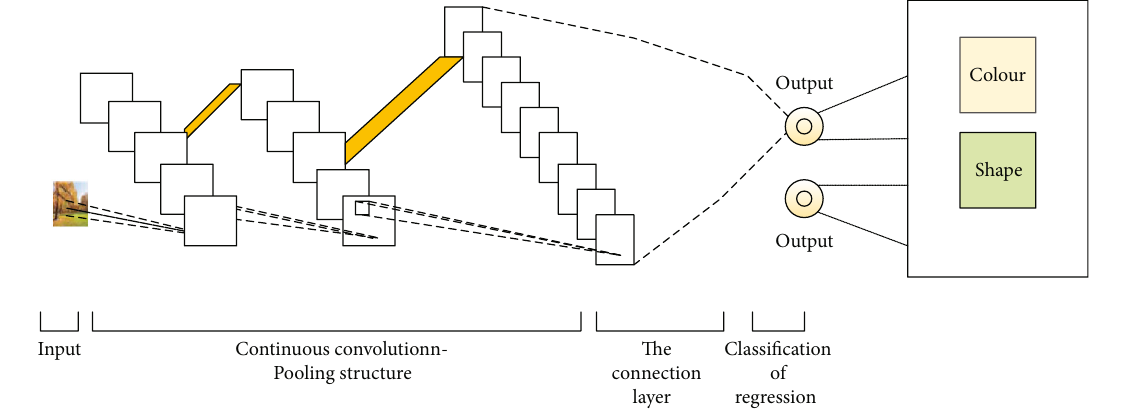
Figure 2: Image recognition structure.